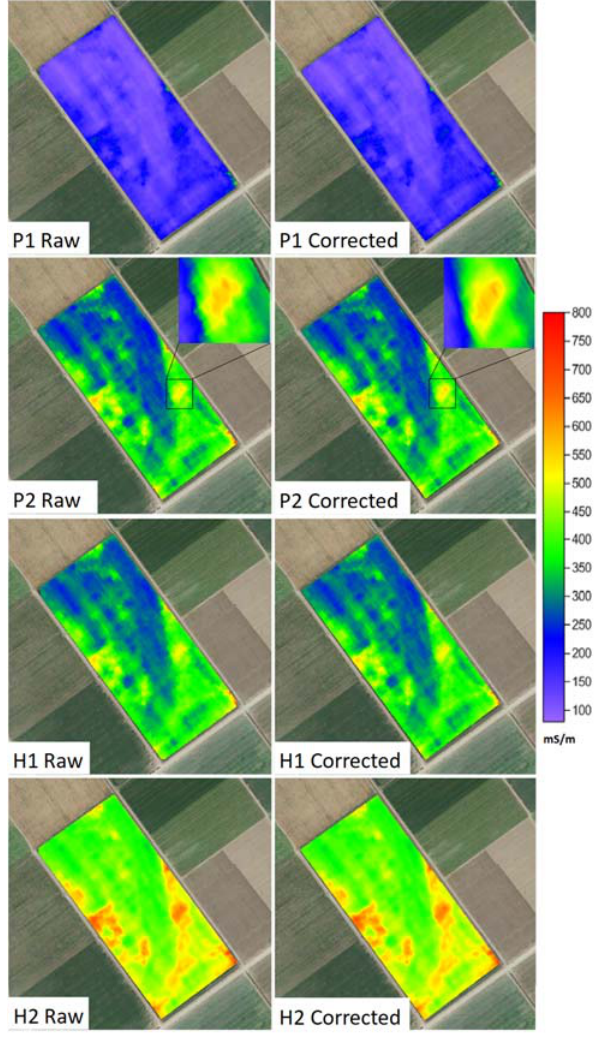
Figure 8. ECa maps for the four signals with raw and corrected coordinates. The inset for the P2 signal shows in detail how the sawtooth pattern disappears for the corrected